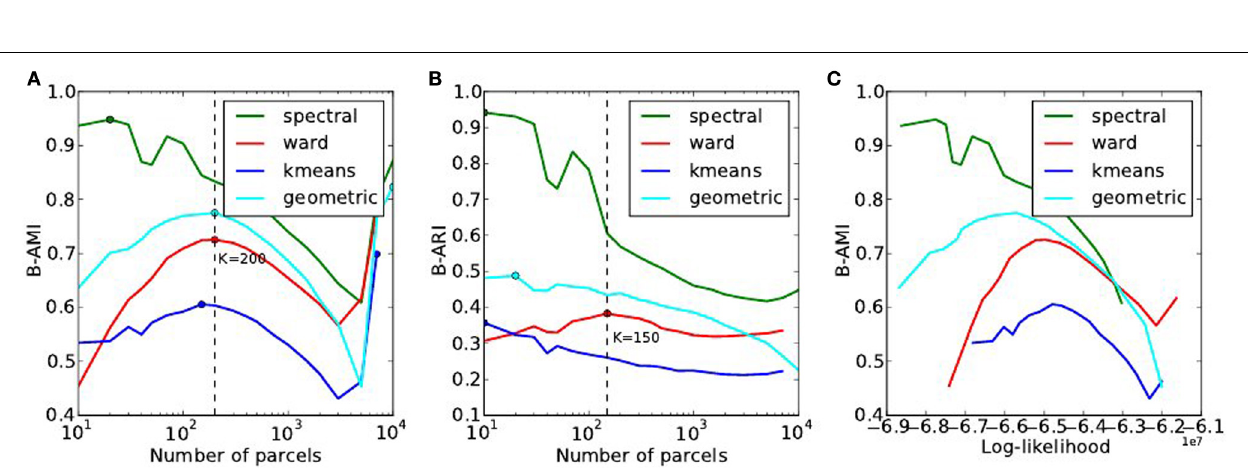
The Bayesian Information Criterion (B) with the sign flipped for the sake of visualization- and the cross-validated log-likelihood (C) , that can be used to identify the right model show the same behavior as the log-likelihood function.